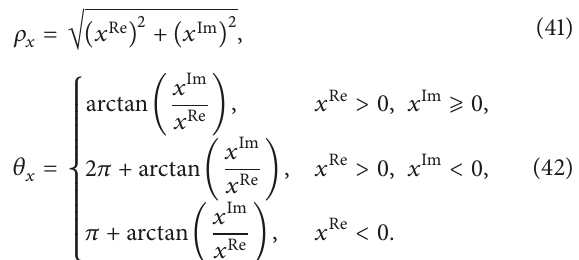
Figure 7 models the modules errors and phases errors of main system (34) and slave systems (35). It is clear from Figures −𝜌 𝜌 −𝜌 7(a), 7(b), and 7(c) that the modules errors 𝜌 𝑥 𝑥 𝑠 , 𝑦 𝑚 𝑦 𝑠 , 𝑚 − 𝜌 𝑡 → ∞ , while the phases and 𝜌 𝑧 𝑧 𝑠 converge to zero as 𝑚 − 𝜃 𝜃 − 𝜃 𝜃 − 𝜃 𝜋/2 or −𝜋/2 as errors 𝜃 𝑥 𝑥 𝑠 , 𝑦 𝑚 𝑦 𝑠 , and 𝑧 𝑚 𝑧 𝑠 go to 𝑚 𝑡 → ∞ ; see Figures 7(d), 7(e), and